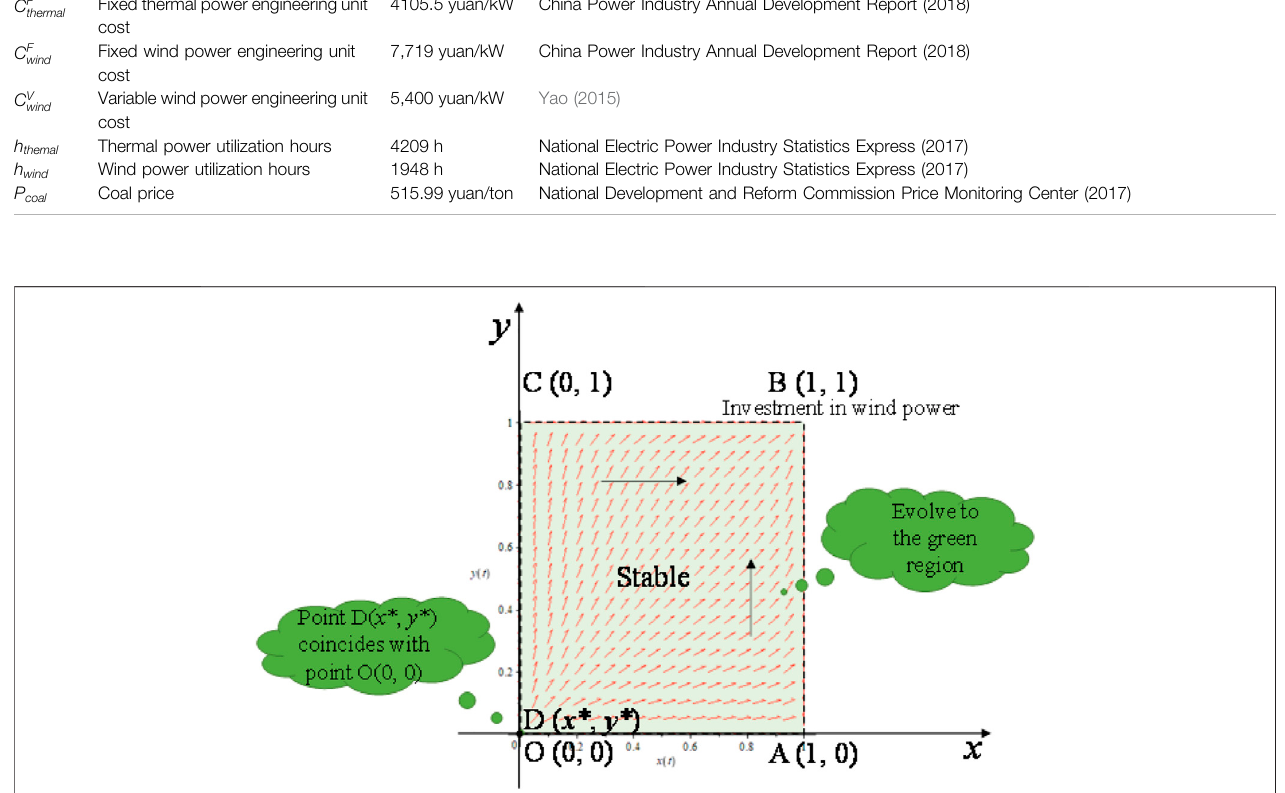
FIGURE 3 | Simulation results in the basic